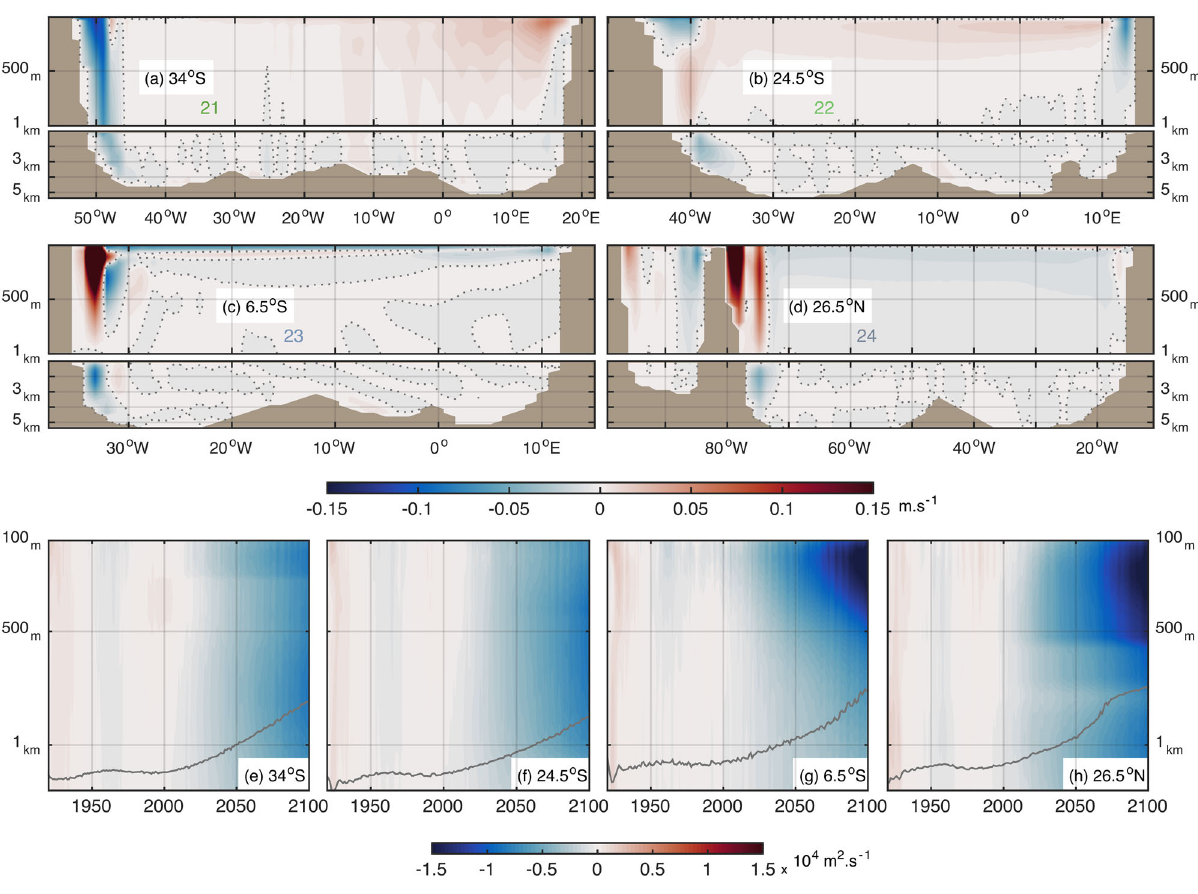
Fig. 3 Projected weakening of the AMOC upper limb from 34 ∘ S to 26.5 ∘ N. a – d Transbasin meridional velocity pro fi les (1920 – 2100 mean) at 34 ∘ S, 24.5 ∘ S, 6.5 ∘ S and 26.5 ∘ N, respectively. Red (blue) represents mean northward (southward) velocities. e – h Hovmoller diagrams of zonally integrated meridional velocity anomalies along transbasin sections corresponding to a – d . Blue (red) represents negative/southward (positive/northward) anomalies. The gray fi lled contour marks the 1920 – 2100 evolution of the zero meridional velocity line that delimits the lower limit of the AMOC upper limb. The upper 100-m of Hovmoller diagrams are not shown since it re fl ects near-surface dynamics within the Ekman layer, which are out of our